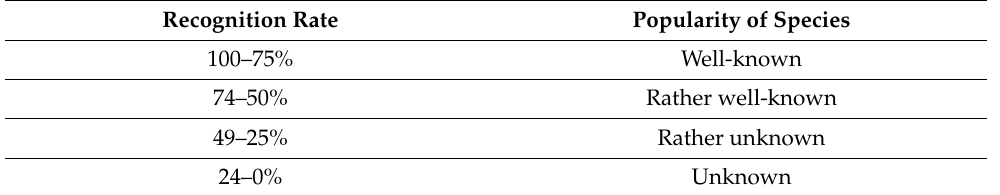
Table 2. Different categories of popularity defined by the recognition rates of the bird